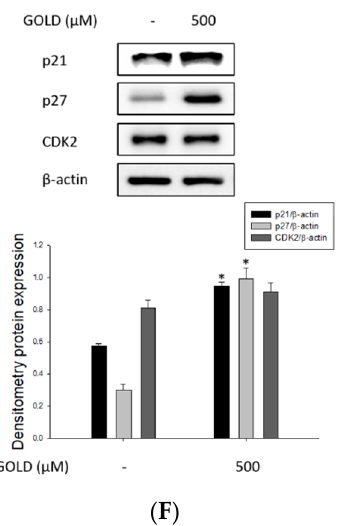
Figure 3. Effects of GOLD on inflammatory mediators, ROS production, and cell cycle. SV40 MES 13 cells were treated with GOLD (500 μM) for 30 min or 24 h. ( A , B ) Reactive oxygen species (ROS) production was determined as described in the Materials and Methods. Mesangial cells were treated with vehicle (medium) in the presence or absence of GOLD (500 μM) for 30 min. The amount of ROS in mesangial cells was analyzed using confocal microscopy. ( C ) Cells were incubated with anti-RAGE primary antibodies, followed by FITC-labeled anti-rabbit IgG. Cells were observed under fluorescence microscopy at ×400 magnification. ( D , E ) The phosphorylation levels of MAPK and the production of proinflammatory cytokines were detected using Western blotting. ( F ) Mesangial cells were incubated for 30 min in the absence or presence of GOLD (500 μM). The levels of cell cycle-related proteins were evaluated using Western blotting. ( G ) SV40 MES 13 cells were cultured in a medium containing GOLD (500 μM) for 24 h, fixed with 70% ethanol, stained with propidium iodide solution, and assessed using fluorescence-activated cell sorting. β-actin levels were used as the internal control. Scale bars, 20 μm. Data are expressed as the mean ± SEM of three independent experiments. * p < 0.05 indicates a significant difference compared to the untreated group.